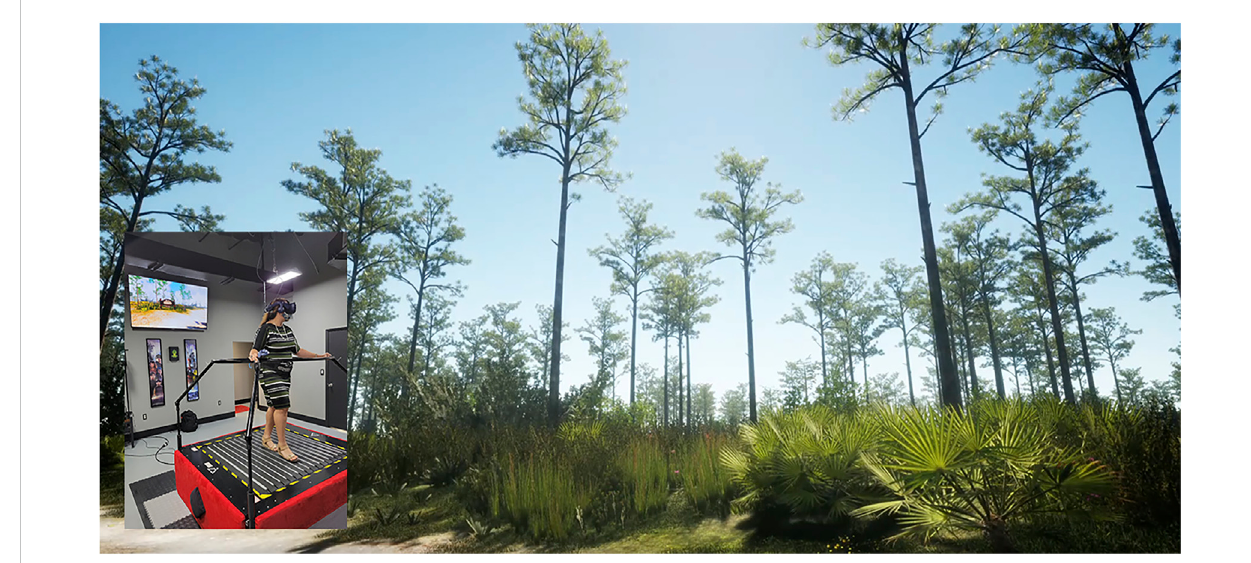
FIGURE 1 Virtual UCF Arboretum image of the environment. Inset is the author using the HTC VIVE VR headset and the In fi nadeck omnidirectional treadmill con fi guration. Harrington, Maria. “ Digital Twins of Nature Demo Reel I/ITSEC 2022 The Harrington Lab. ” Video, 2.03 minutes, November 28, 2022. URL: https://youtu.be/FP9Ottj7cCA.